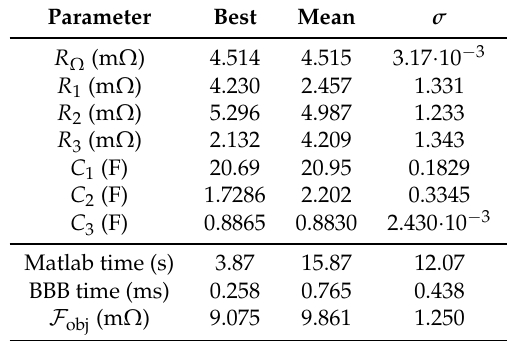
Table 1. Identification on Fouquet data [14] by using the third order linear model.